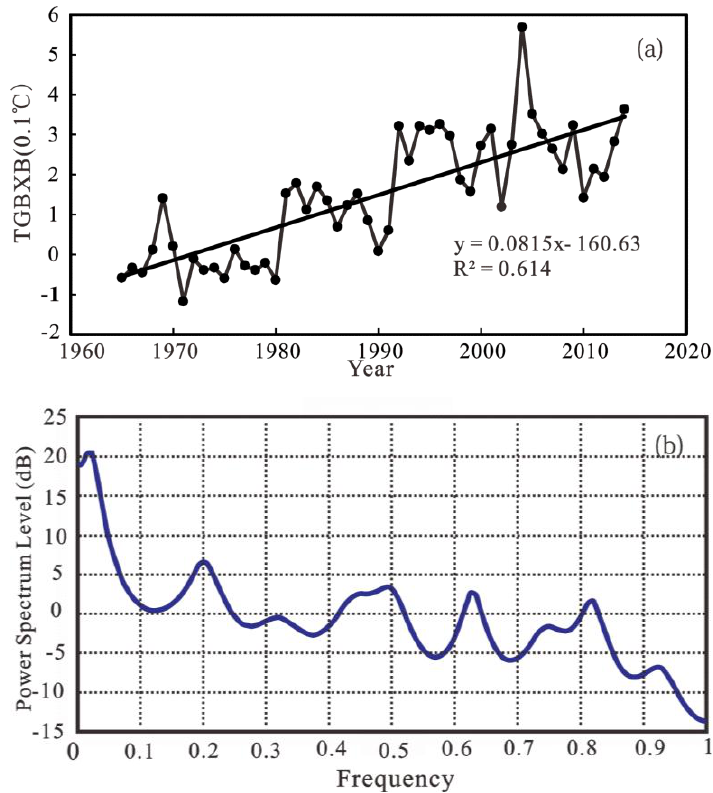
Figure 7. Temperature gap between Xujiahui and Baoshan (TGBXB) in Shanghai and its Maximum Entropy Spectrum (MES): ( a ) TGBXB in Shanghai from 1965 to 2014; and ( b ) the MES of TGBXB in Shanghai.